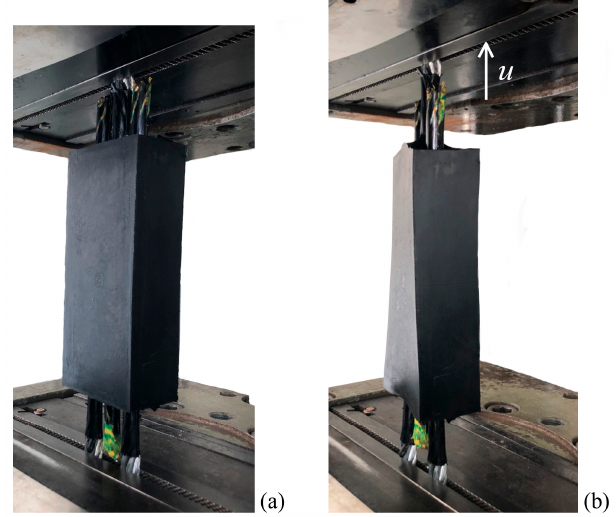
Figure 1. A three-cable specimen: ( a ) unloaded and ( b ) vertically loaded with a twist due to a tension/torsion coupling of the cables.